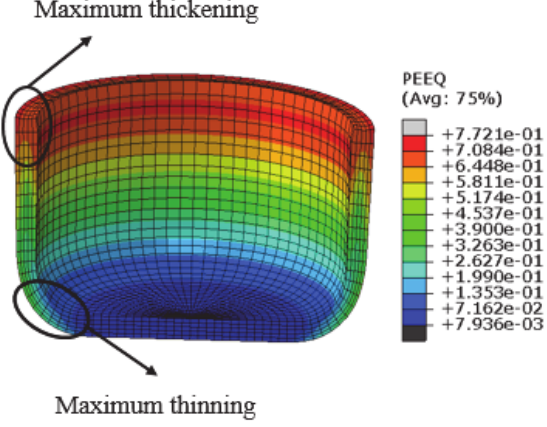
Fig. 1. Maximum thickening and thinning in the final